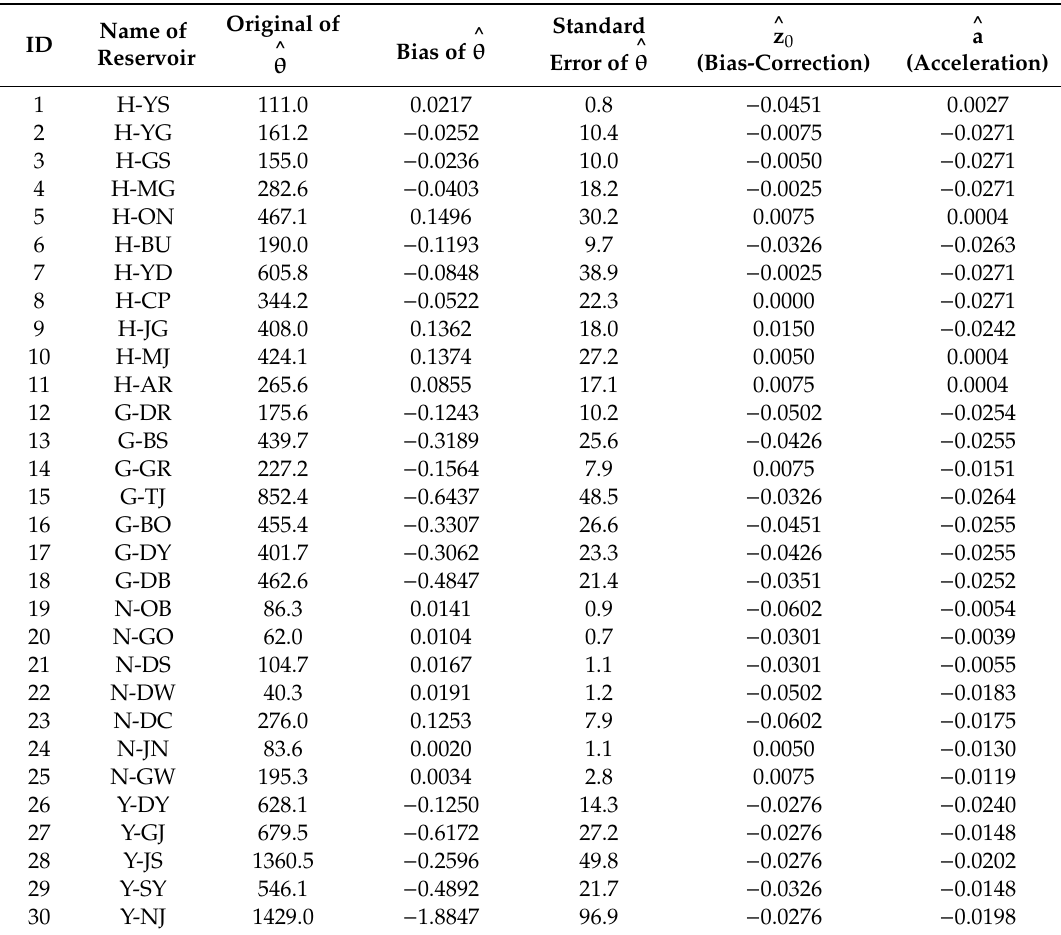
Table 3. Bootstrap inference result for the inflow design flood for a 24-h duration and a 200-y return period for 2040s (2011–2040) under the RCP4.5 scenario. The estimator (ˆ θ ) is the mean, ˆz 0 denotes the constant for correcting the bias of the re-extracted sample, and ˆa denotes the constant for correcting the skewness of the re-extracted sample.